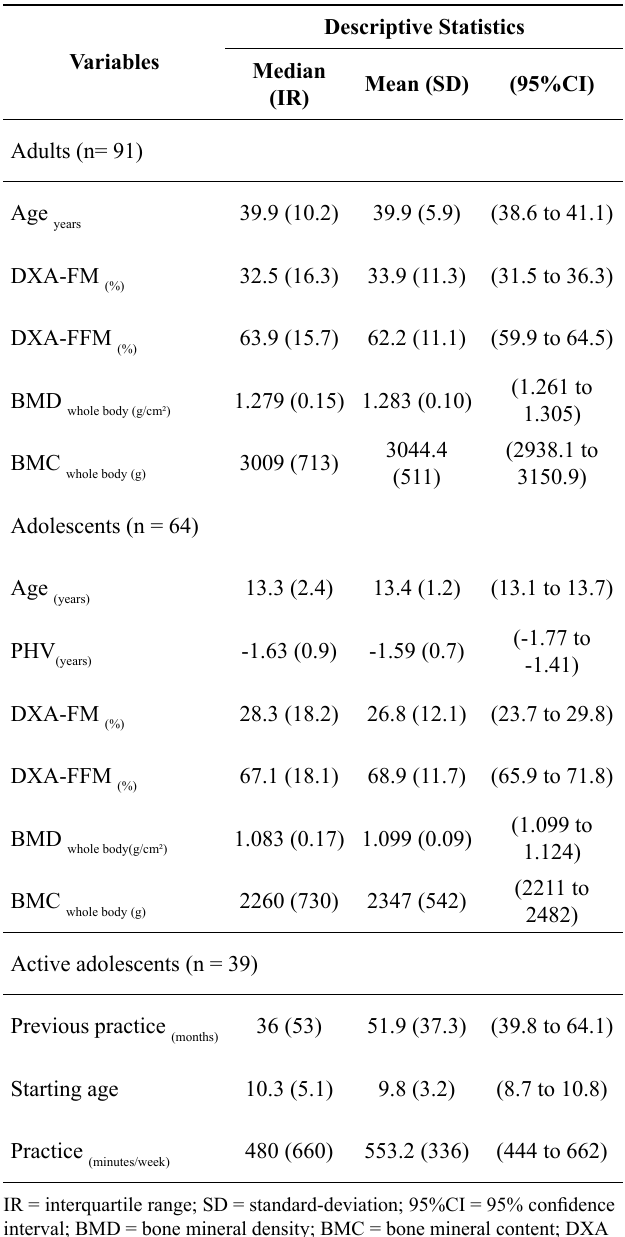
Table 1 . General characteristics of the adolescents and adults ana- lyzed in the study (n =